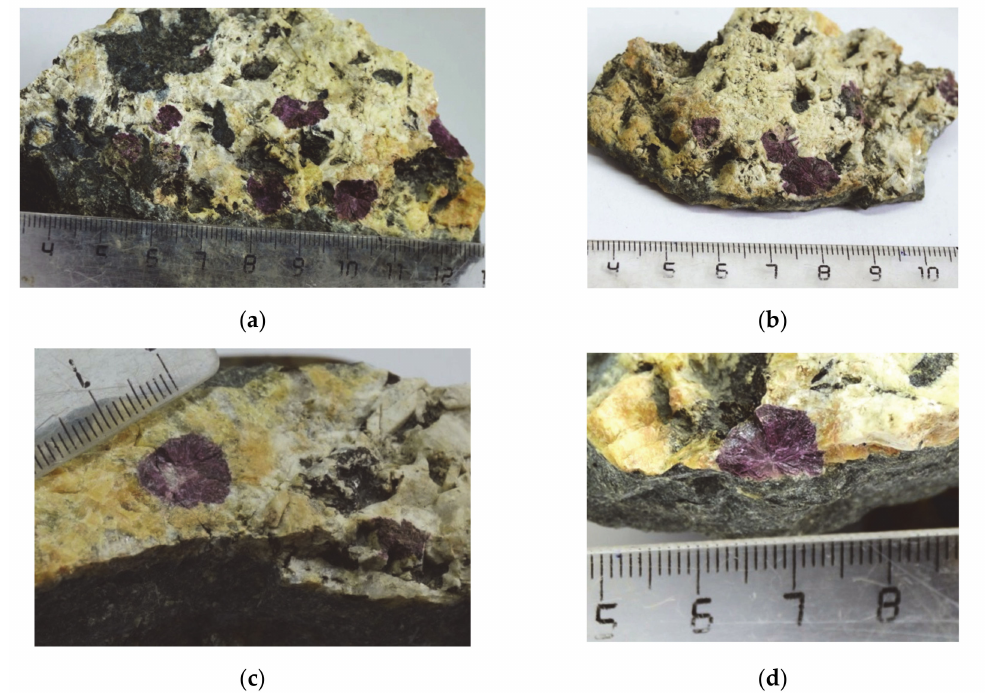
Figure 1. Odikhinchaite aggregates (purple rosettes) in pegmatite with white alkali feldspars, yellow cancrinite and dark green to black aegirine.